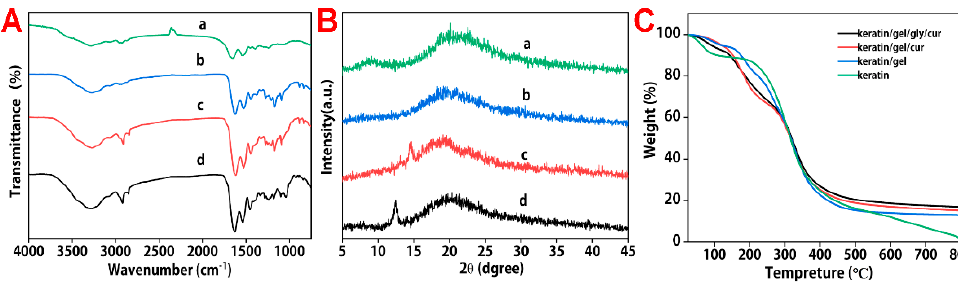
Figure 5. FTIR ( A ), XRD ( B ), and TGA ( C ) spectra of ( a ) pure keratin, ( b ) keratin/gelatin, ( c ) keratin/gelatin/ curcumin, and ( d ) keratin/gelatin/glycerin/curcumin composite films. atin/gelatin/ curcumin, and ( d ) keratin/gelatin/glycerin/curcumin composite